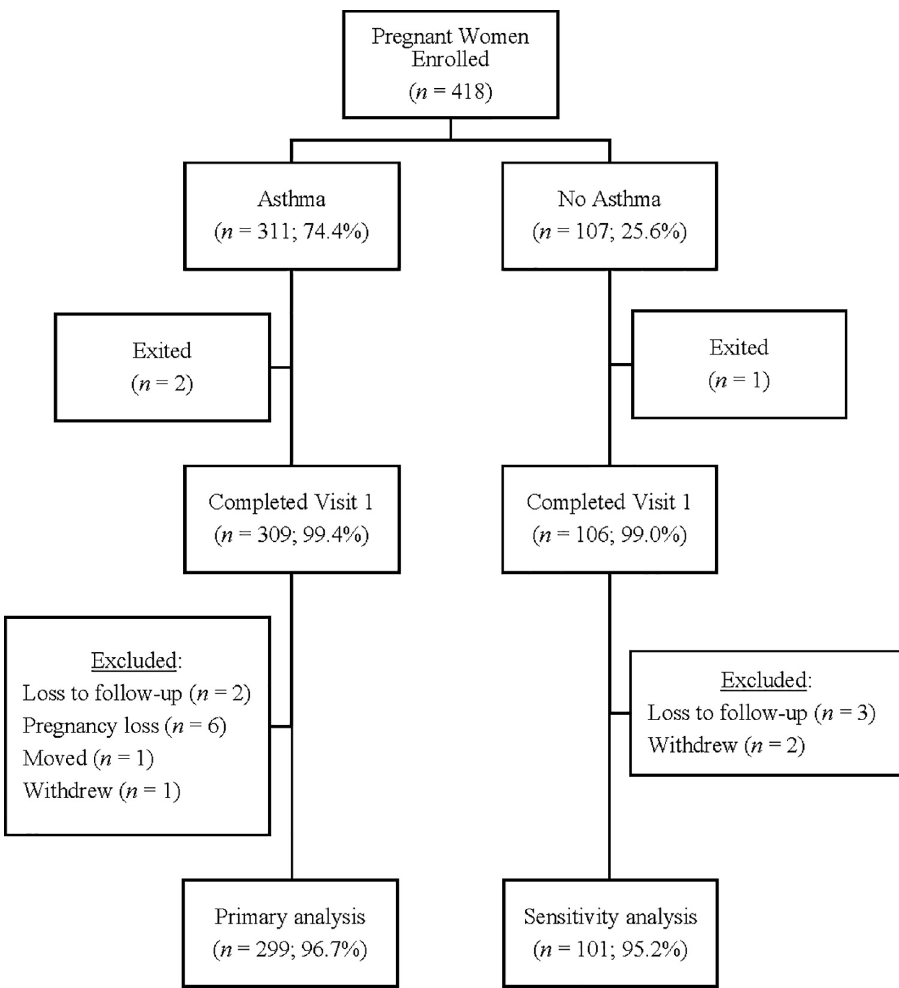
Fig 1. Flow diagram of study population for women in the Breathe-Wellbeing, Environment, Lifestyle, and Lung Function Study, 2015–2019,